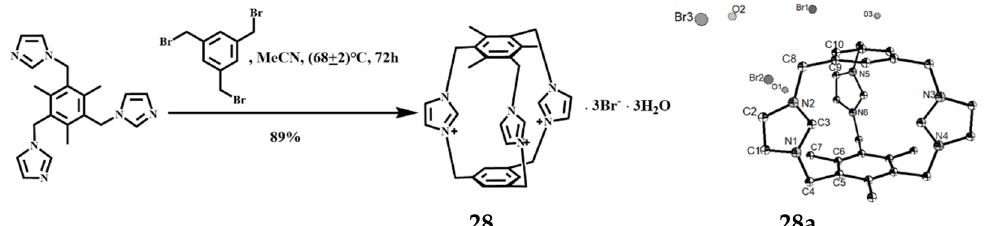
Figure 16. Synthesis and ORTEP drawing of a speleand imidazolium cyclophane 28 (the probability of thermal ellipsoid is 50%).